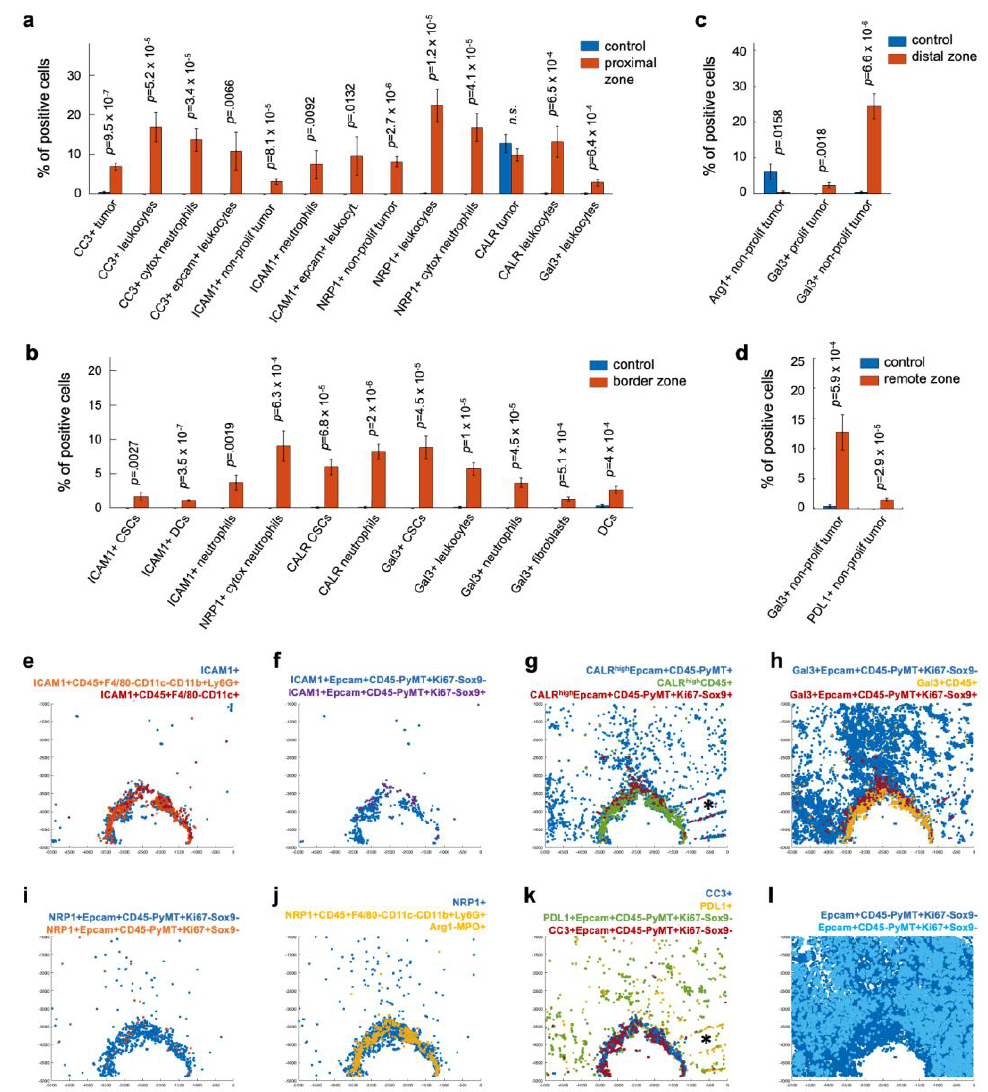
Figure 5. Quantification of significantly altered cellular phenotypes and their spatial expression in panobinostat-treated tumor samples . ( a ) Quantification of significantly changed biomarker com- binations defining cell-type-specific candidate marker expression in proximal ( a ), border ( b ), distal ( c ), and remote ( d ) regions and their presentation in the XY-coordinate system ( e – l ). Late-stage MMTV-PyMT tumors were implanted with panobinostat-loaded microdevices, and the drug was passively released for three days. n = 5, 6, 6, and 7 regions for the proximal, border, distal, and remote zones, respectively. Bars are means ± s.e. * folded tumor tissue was excluded from the anal- ysis.